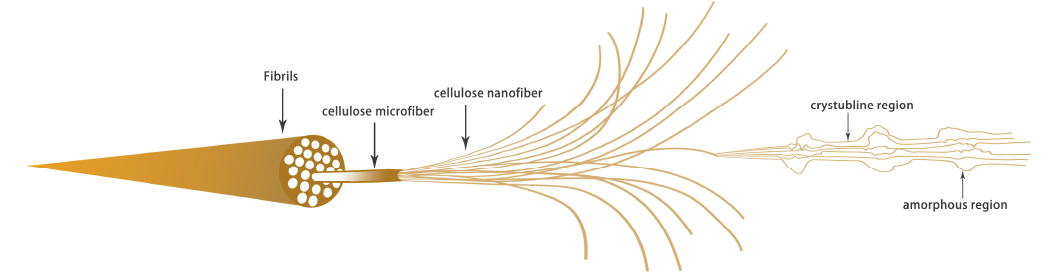
Figure 2. Internal structure of cellulose.